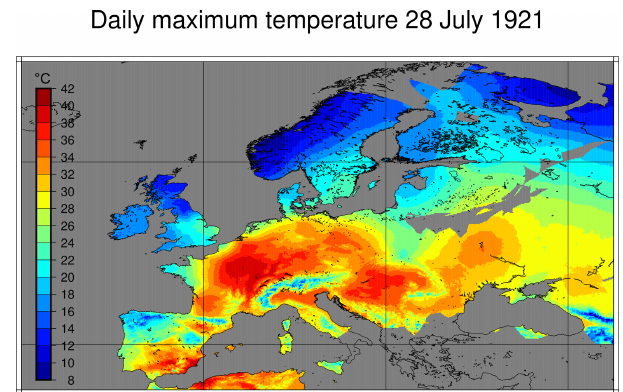
Figure 10. Map showing the daily maximum temperature for 28 July 1921 at the peak of the heatwave in France. Based on the E-OBS